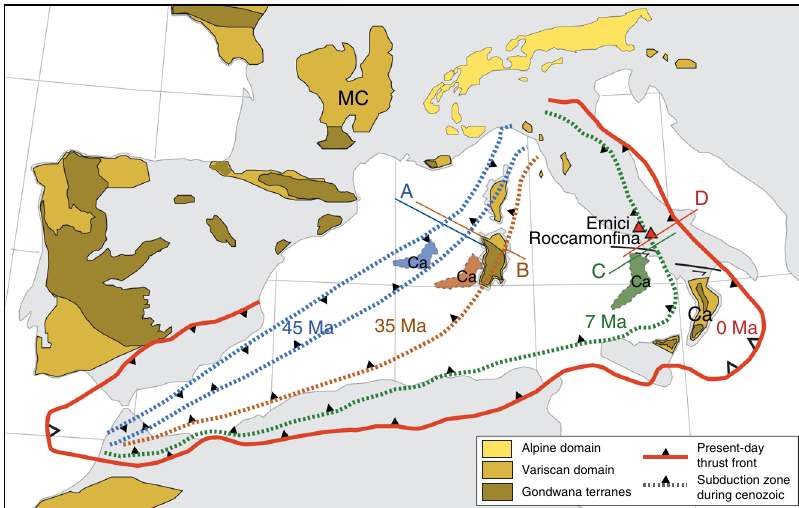
Fig. 1 Schematic map of the Western Mediterranean indicating the Roccamon fi na and Ernici volcanoes. The migration of the subduction zone since the Eocene (stippled lines) and the presence of Variscan and peri-Gondwanan terranes in the region are indicated (modi fi ed after refs. 8,10,14,64,75 ). The arc changed subduction polarity from south-east to northwest at around 45 Ma (blue) and migrated eastward to its indicated position at 35 Ma (brown). Continued subduction and roll-back caused signi fi cant fore- and back-arc extension and migration of the Calabria segment (Ca) towards the East at 7 Ma (green), and to its current location to meet the Dinarides continental lithosphere at 0 Ma (red). Regions of the thrust front with active subduction are indicated with larger open symbols. Coloured lines with labels A – D represent the locations of pro fi le cartoons in Fig. 5. Red triangles represent the current location of Roccamon fi na and Ernici on peninsular Italy. MC: Massif